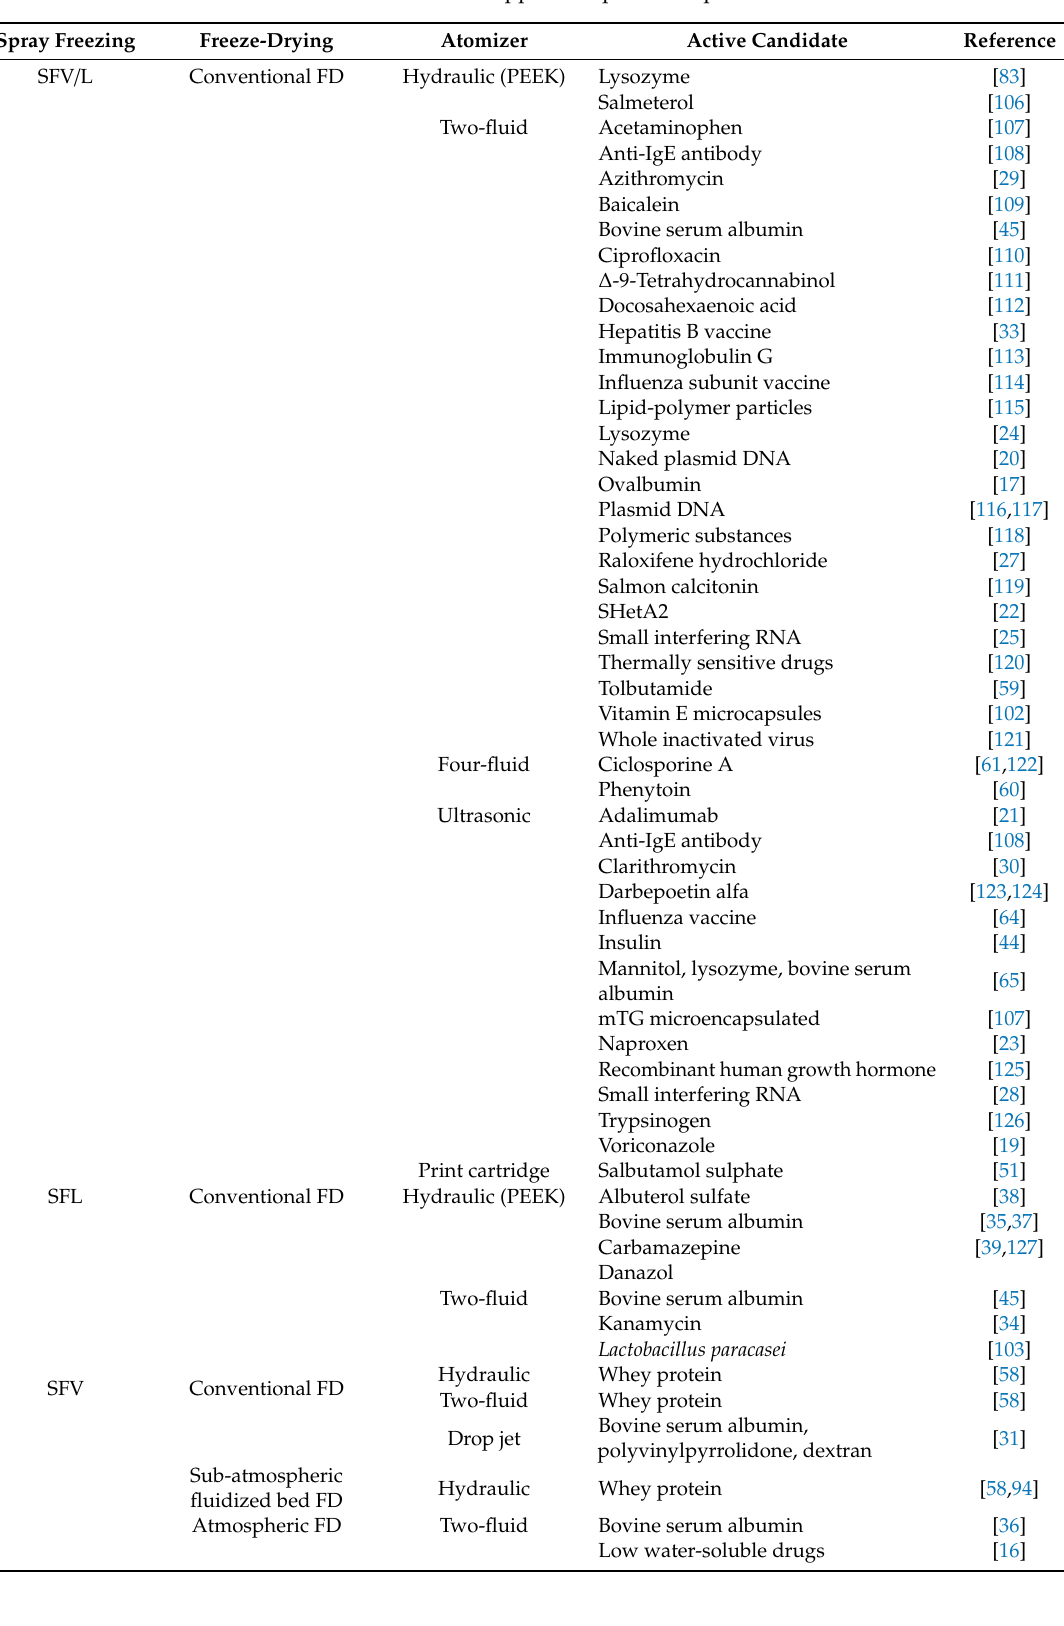
Table 3. Combination of applied steps of SFD